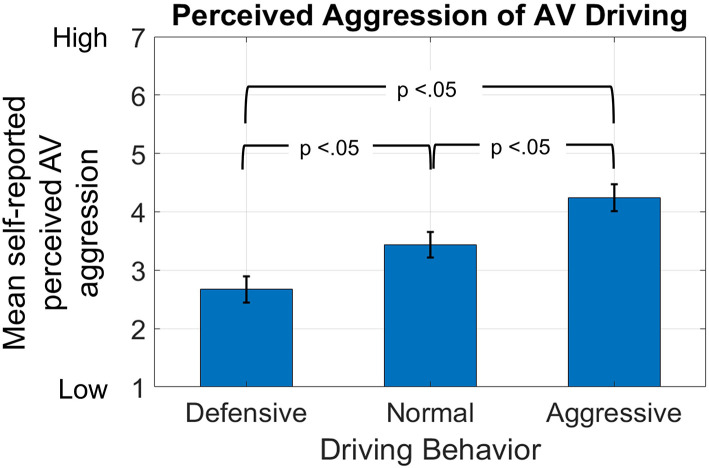
Manipulation check of aggressive driving. Perceived aggression of automated vehicle (AV) driving is lowest for defensive driving and highest for aggressive driving conditions.